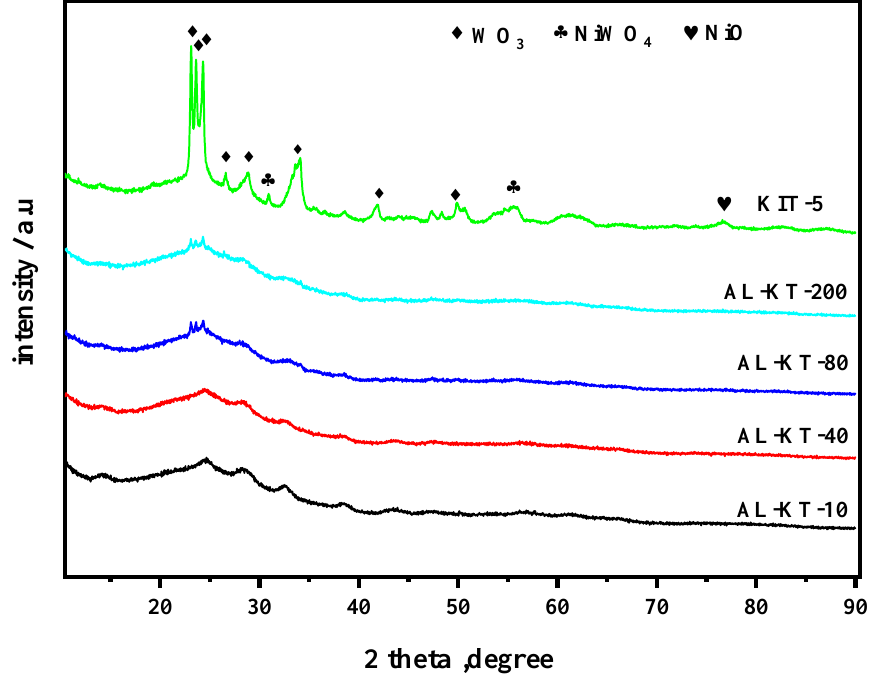
Figure 7. Wide-angle XRD patterns of the NiW/Al-KT-X and NiW/KIT-5 catalysts.